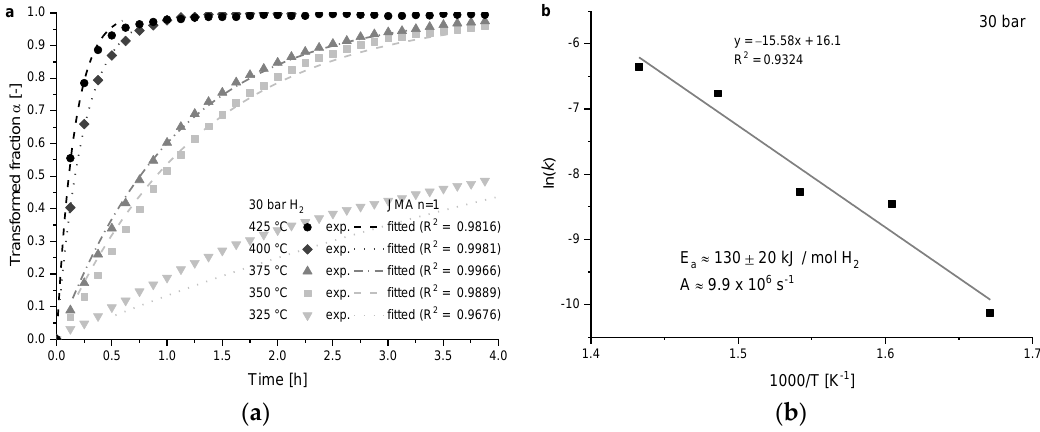
Figure 3. ( a ) Transformed fraction α plotted vs time under 30 bar of H 2 at different temperatures with the relative fits by JMA n = 1 model; ( b ) The corresponding calculation of the activation energy value, applying Arrhenius equation.